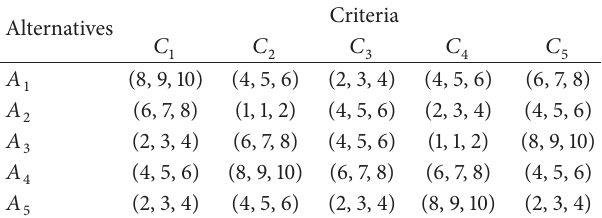
Table 5: Individual fuzzy decision matrix of DM 3 . Alternatives